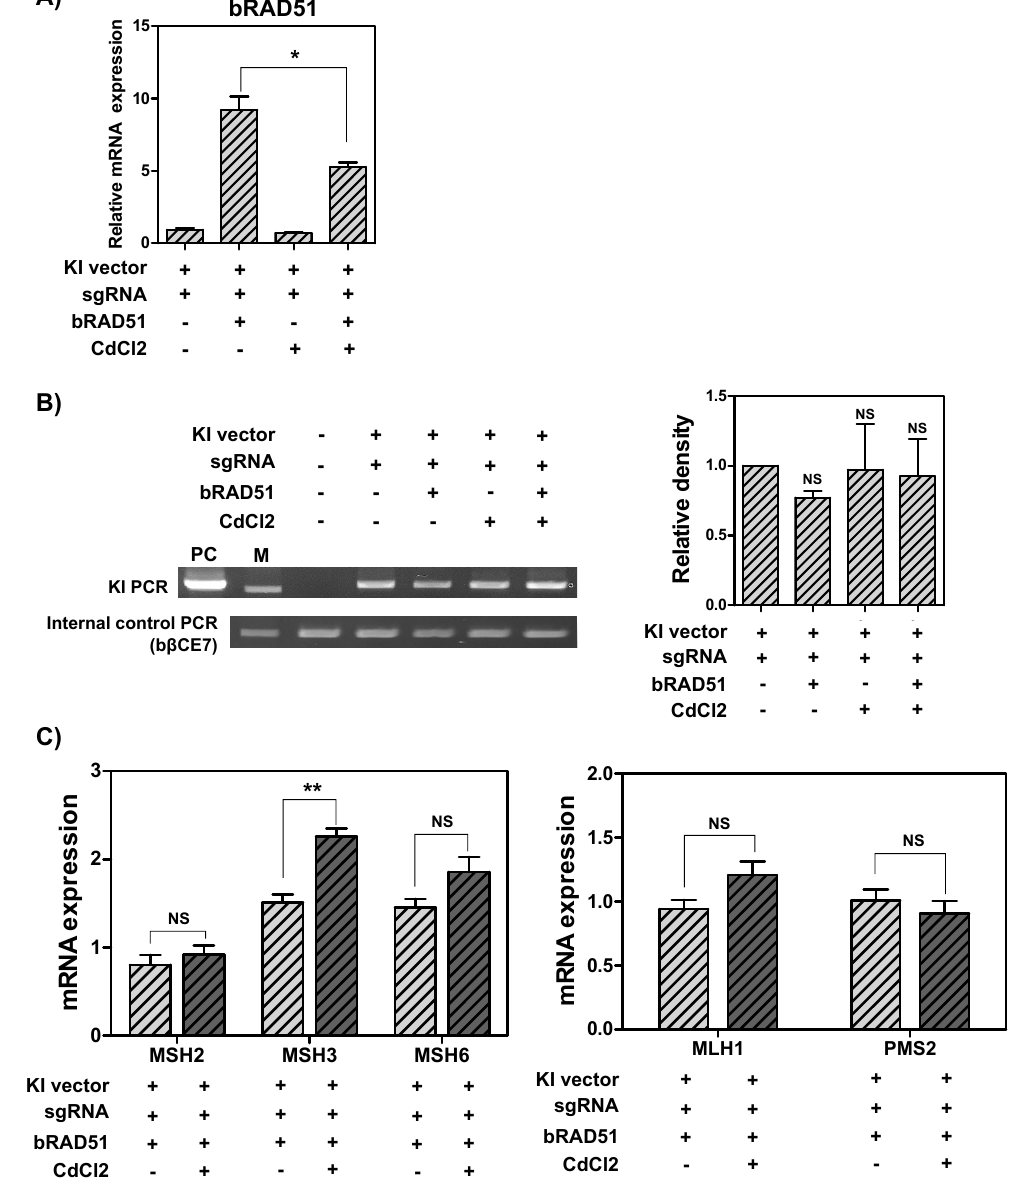
Figure 4. The mRNA levels of RAD51 and DNA MMR-related genes, and CRISPR/Cas9-mediated knock-in efficiency in MAC-T cells induced over - expression of RAD51 and treated with 1 µM CdCl . (A) The mRNA levels of RAD51 gene. (B) Polymerase chain reaction analysis of knock-in effi - 2 ciency. M, DNA size marker (1 kb ladder). (C) The mRNA levels of DNA MMR-related genes. RAD51, RAD51 recombinase; MMR, mismatch repair; CRISPR/Cas9, clustered regularly interspaced short palindromic repeats/CRISPR-associated 9; MAC-T, bovine mammary epithelial cells. Error bars show the standard deviation from each sample. NS, no statistical difference; * p<0.05; **